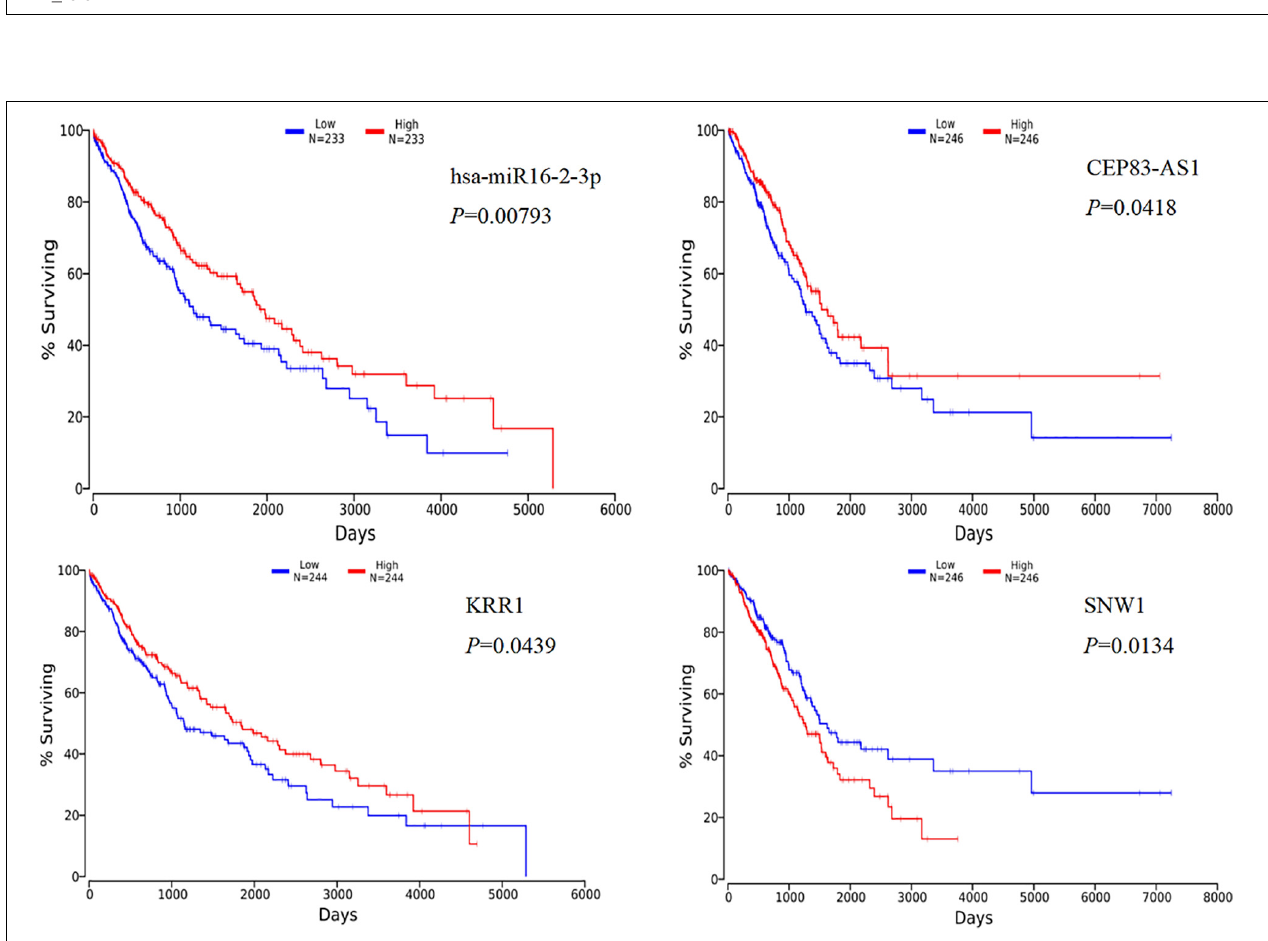
FIGURE 5 | Kaplan-Meier curve analysis of miRNA, lncRNA, mRNA and overall survival in rare-earth pneumoconiosis patients.